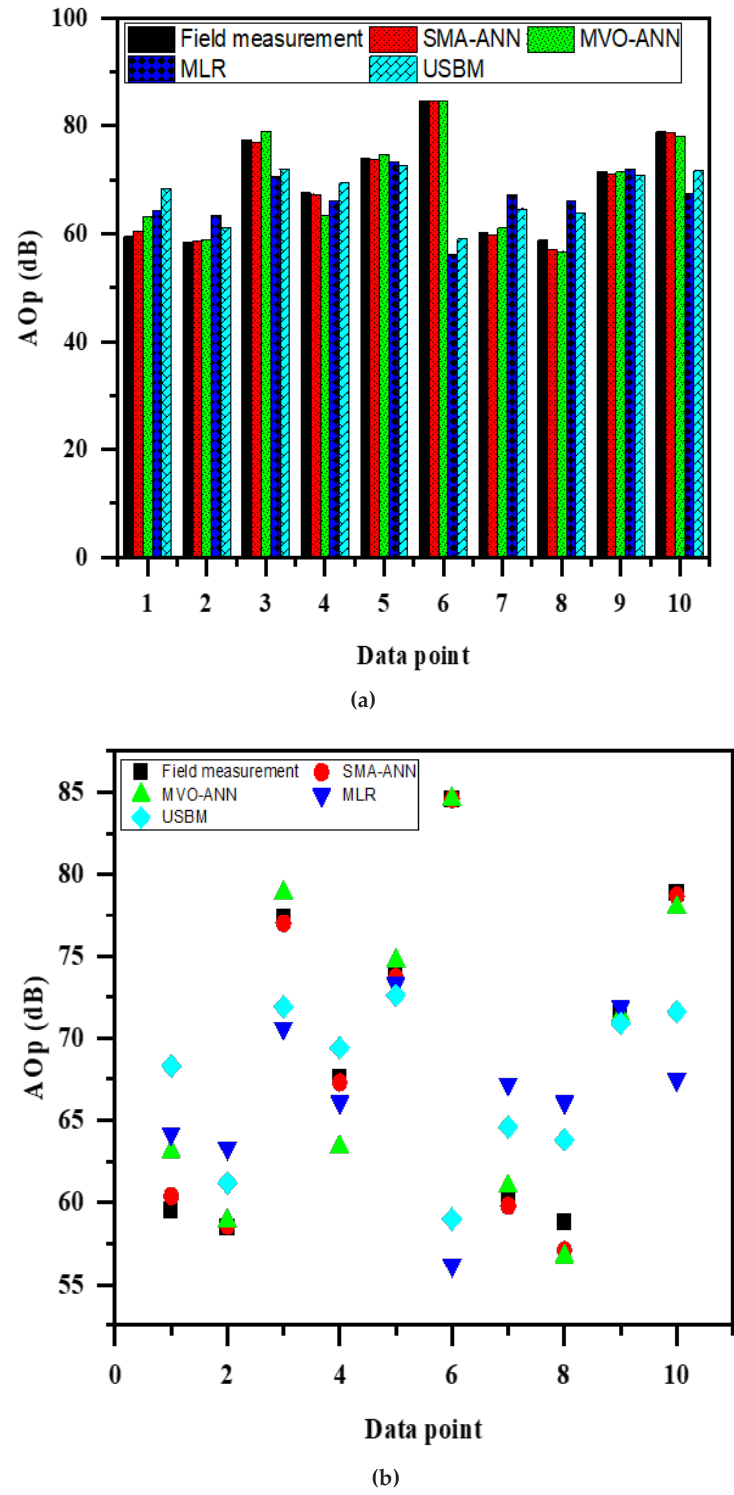
Figure 11. Validation results of the different developed models. ( a ) column graph; ( b ) scatter plot